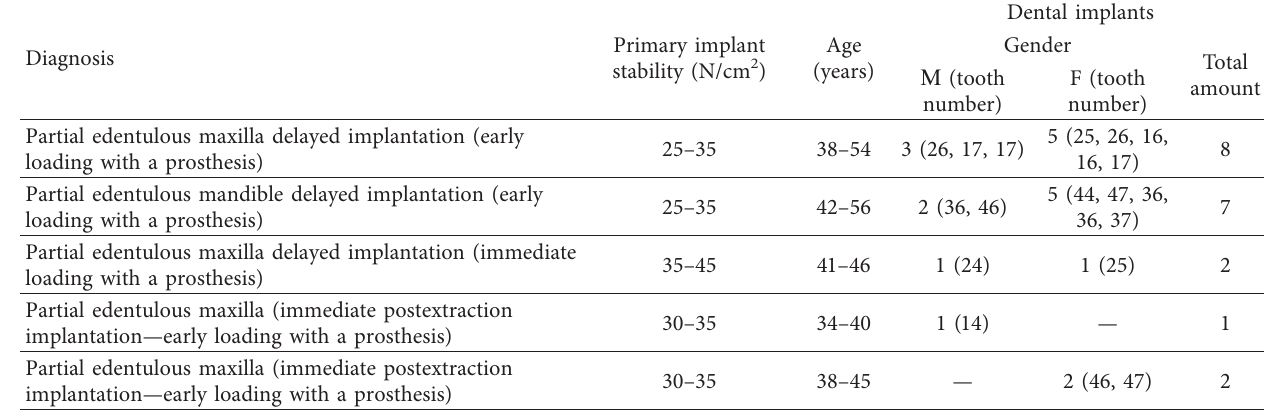
Table 1: Quantitative characteristics of the patients according to age, gender, and nosology.